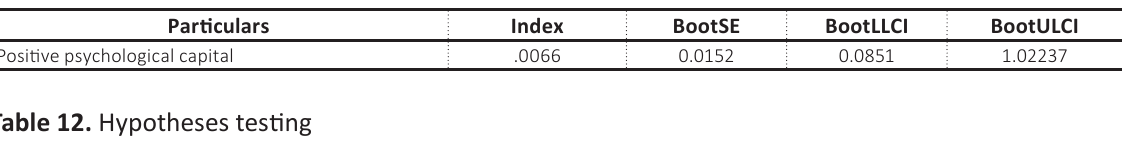
Table 11. Index of mediated moderation